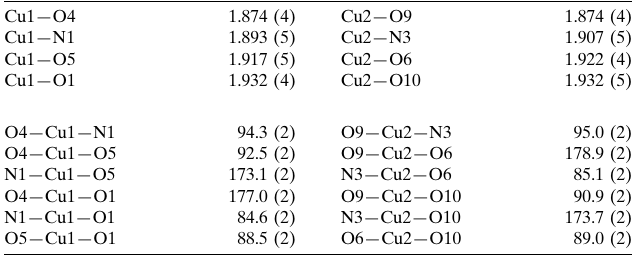
Selected geometric parameters (A˚ , (cid:3) ).